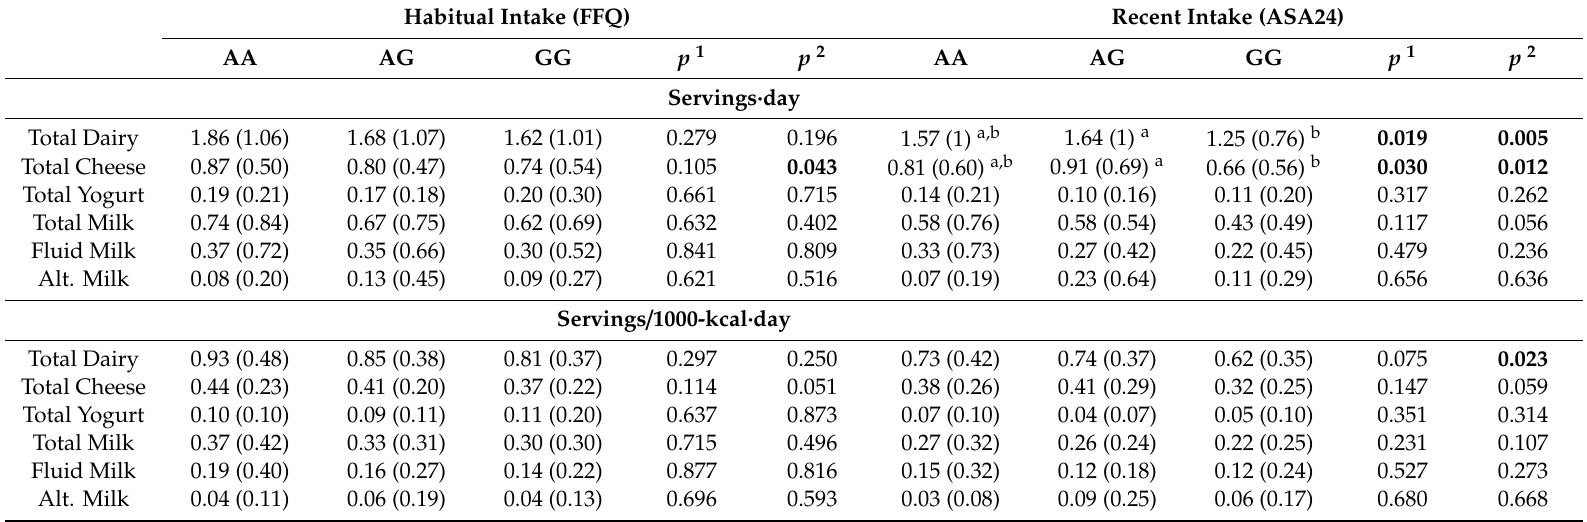
Table 3. Mean (SD) of reported servings and servings / 1000-kcal of each product for all subjects by